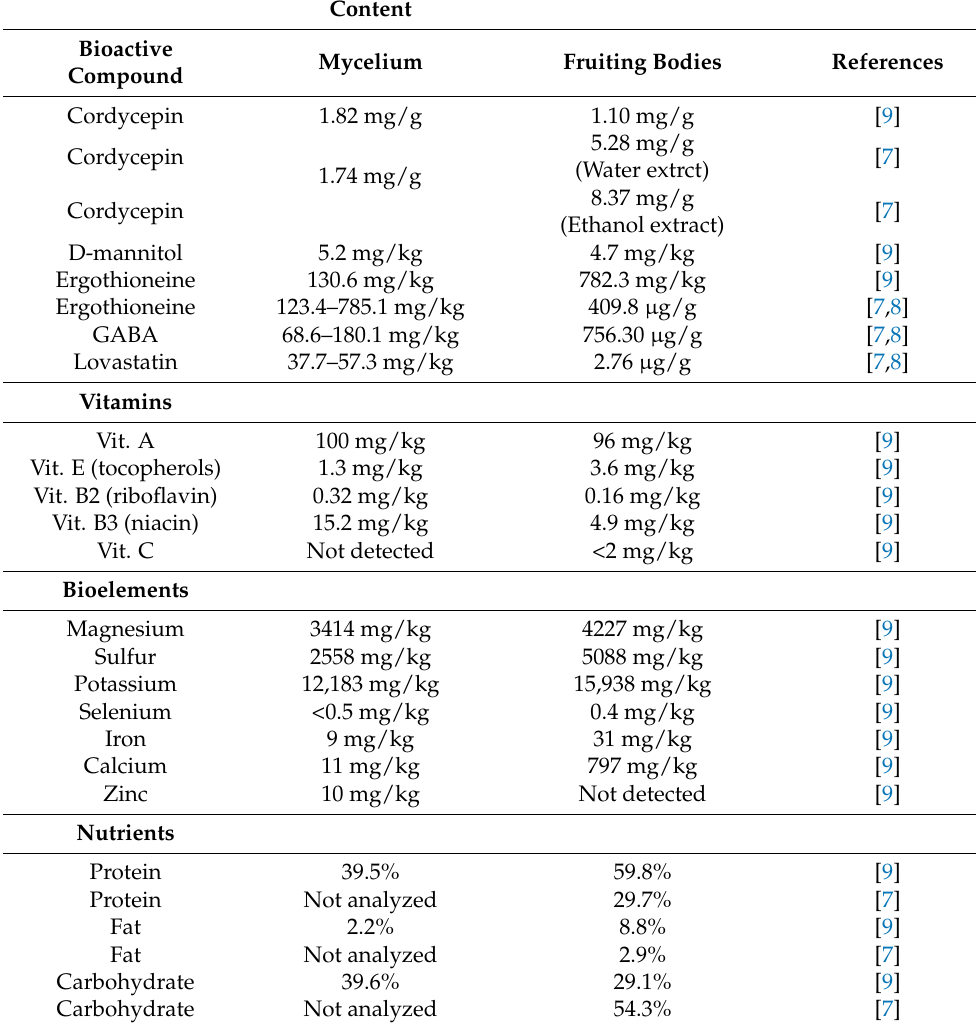
Table 1. Content of bioactive compounds and nutrients present in the mycelium and fruiting bodies of C. militaris